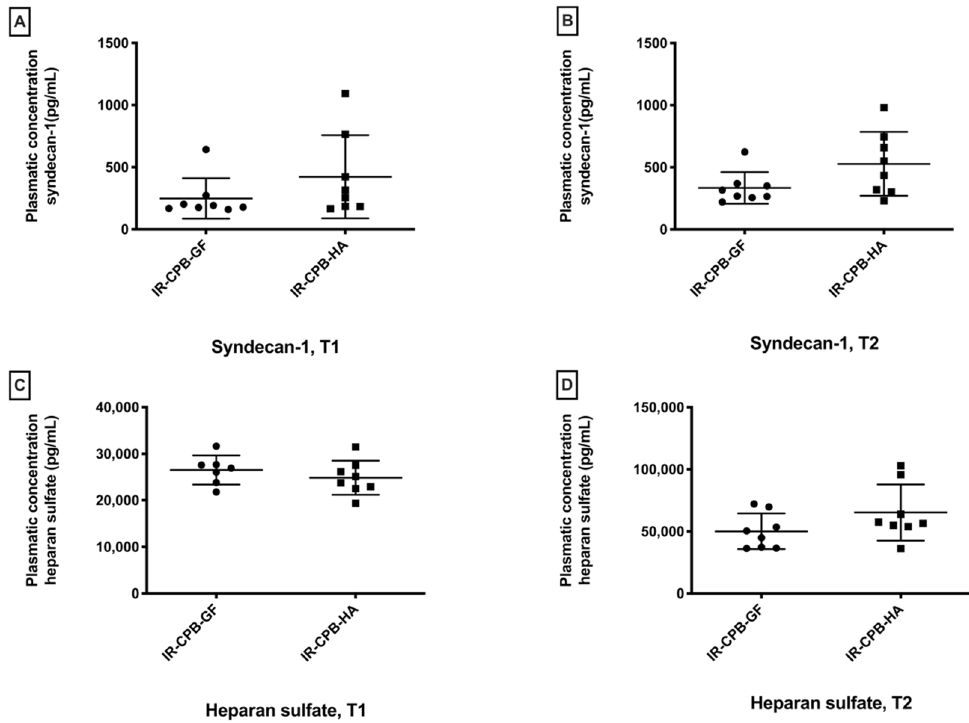
Figure 2. Plasmatic glycocalyx degradation. ( A ) Plasma concentration of syndecan-1 at T1. ( B ) Plasma concentration of syndecan-1 at T2. ( C ) Plasma concentration of heparan sulfate at T1. ( D ) Plasma concentration of heparan sulfate at T2. For statistical analyses, ANOVA was used, followed by Tukey’s multiple comparison (post hoc) testing. A result with p < 0.05 was considered to be statistically significant. Data are presented as mean ± SD. Abbreviations: CPB, cardiopulmonary bypass; IR, left lung ischemia–reperfusion; HA, human albumin.